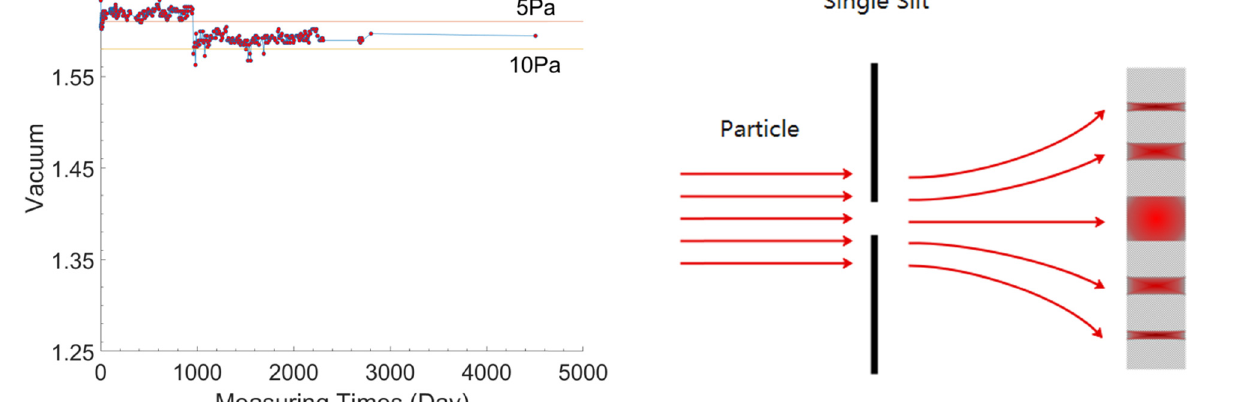
Figure 5: Single - slit di ff raction pattern of particles. In the process of light propagation, when it encounters an obstacle or a small hole, the light will deviate from the straight path of propagation and travel around behind the obstacle. This study assumes that air molecules will also di ff ract when passing through nanochannels.